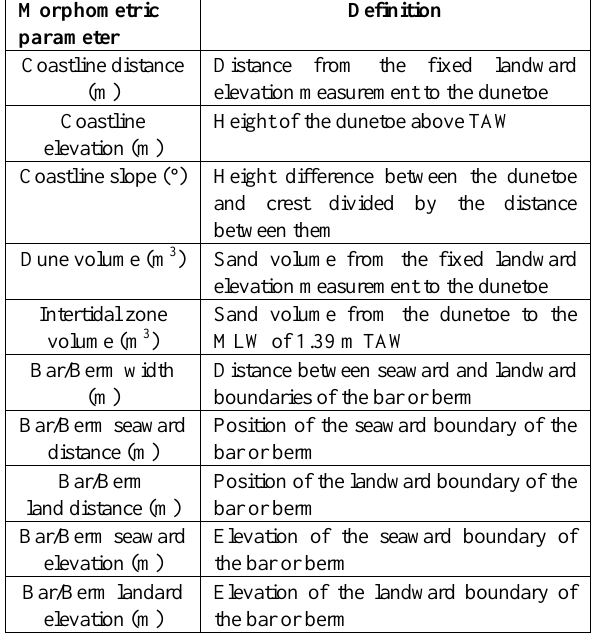
Table 1. Definitions of the morphometric parameters.